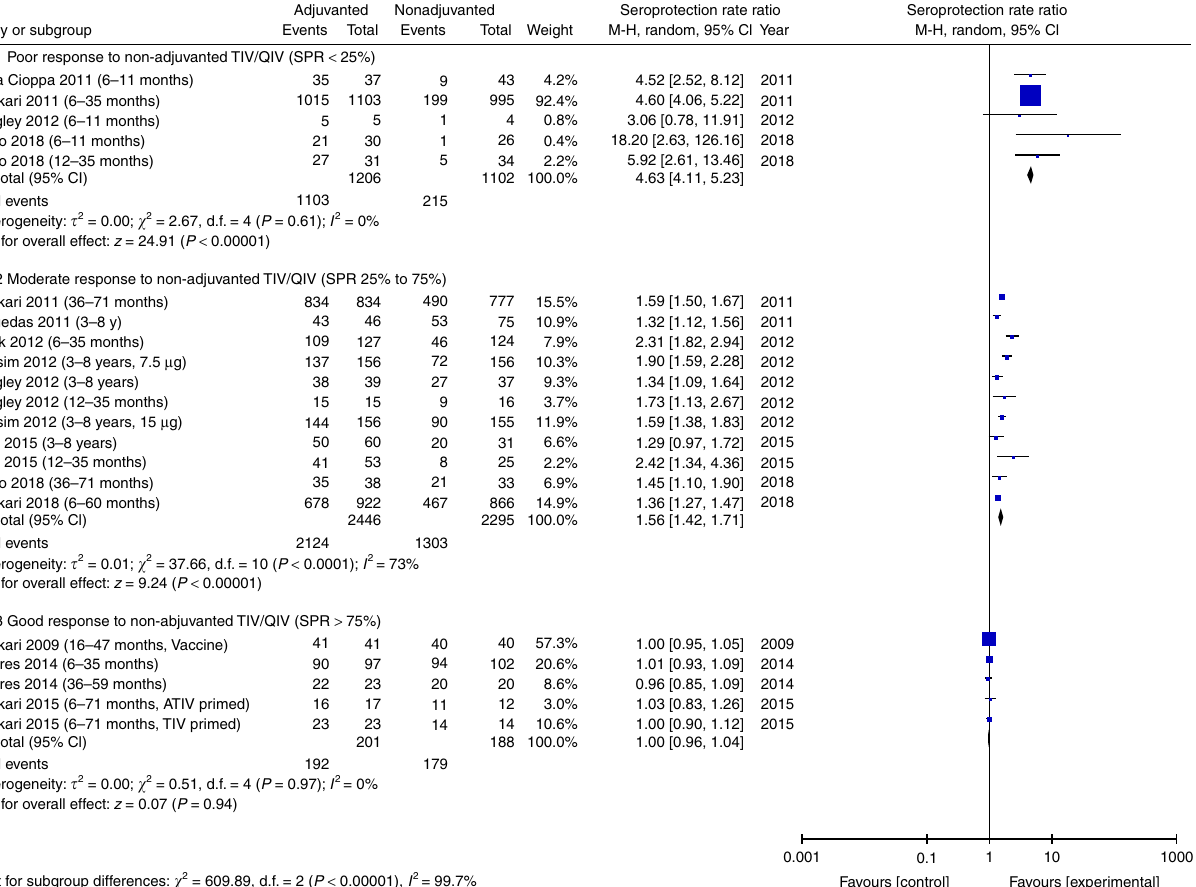
Fig. 3 Forest plot showing the ratios of the seroprotection rate (SPR) against H1N1, de fi ned as a ≥ 1:40 hemagglutinin inhibition (HI) titer, 21 – 28 days after the fi rst dose among children who received adjuvanted versus non-adjuvanted trivalent vaccines (TIVs) or quadrivalent vaccines